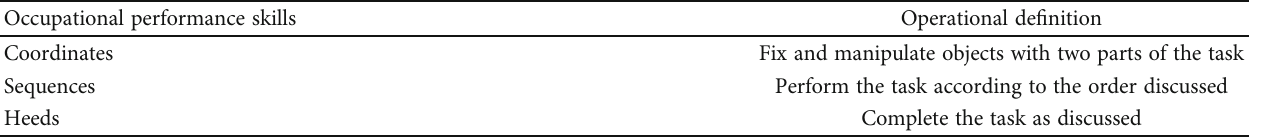
Table 1: Operational de fi nitions of occupational performance skills.